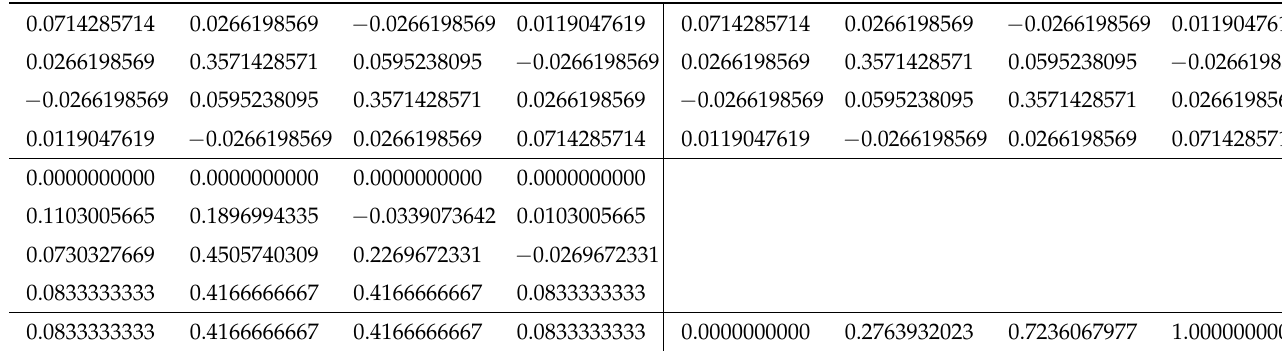
Table A18. L4|L4